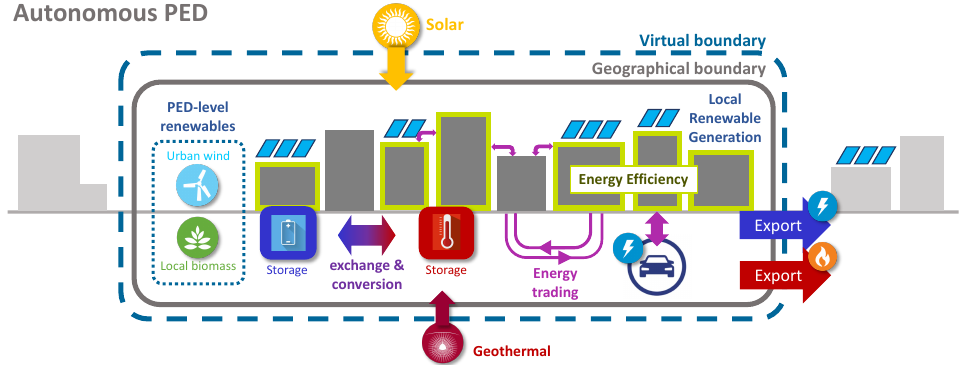
Figure 1. Autonomous PED, principle and system boundaries. Only exports to the surrounding system. Including energy efficiency measures, renewables (solar, PV, wind, biomass, geothermal, small hydropower), waste heat recovery, electric and thermal storage, integration of mobility energy needs (and EVs as batteries), sector coupling between electric and thermal.